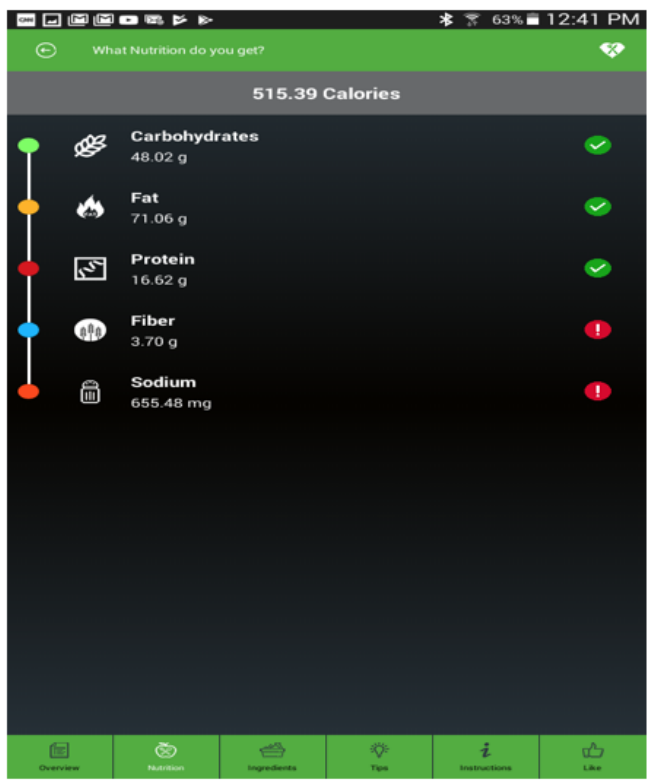
Figure 5. Nutrition break down of the